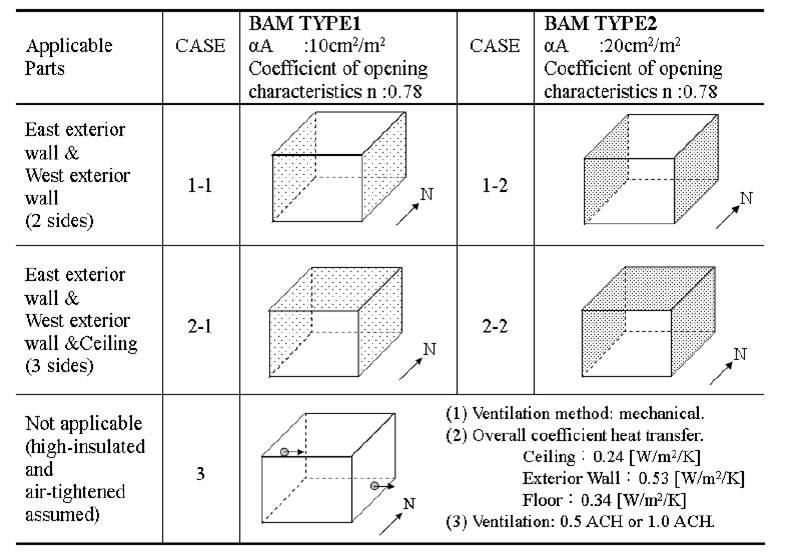
Figure 10. House models used for the simulations